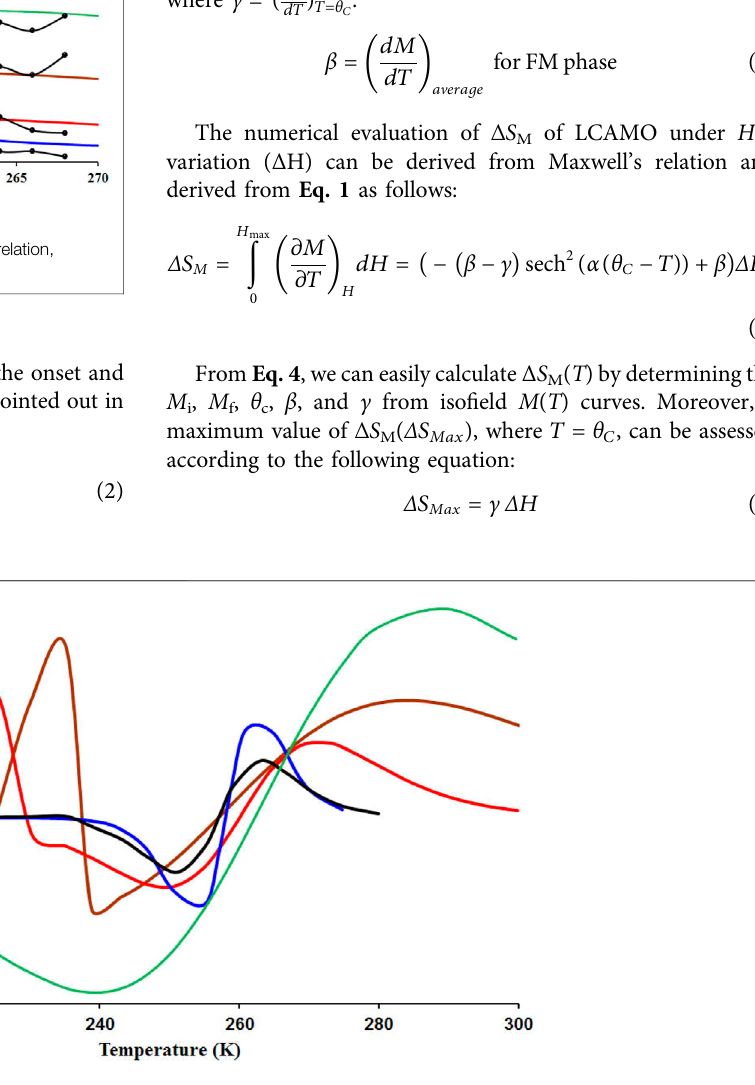
FIGURE 4 | Δ C P,H vs . temperature for La 0.5 Ca 0.1 Ag 0.4 MnO 3 .